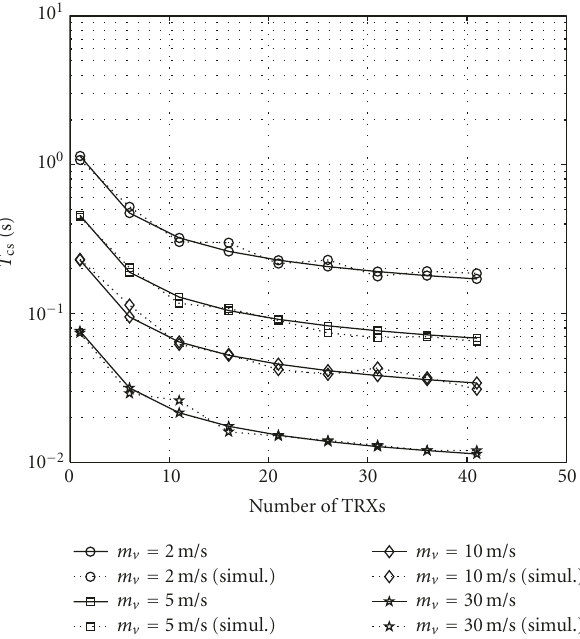
Figure 10: Cyclostationarity coherence time for multiple transpon-